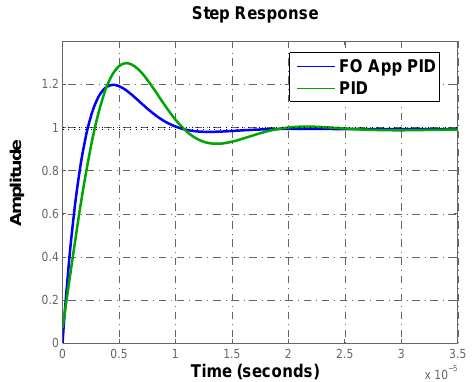
Figure 8. Comparison of the step response of the minimum phase part of the boost converter (7) when fractional-order PID controller approximation and typical PID controller are